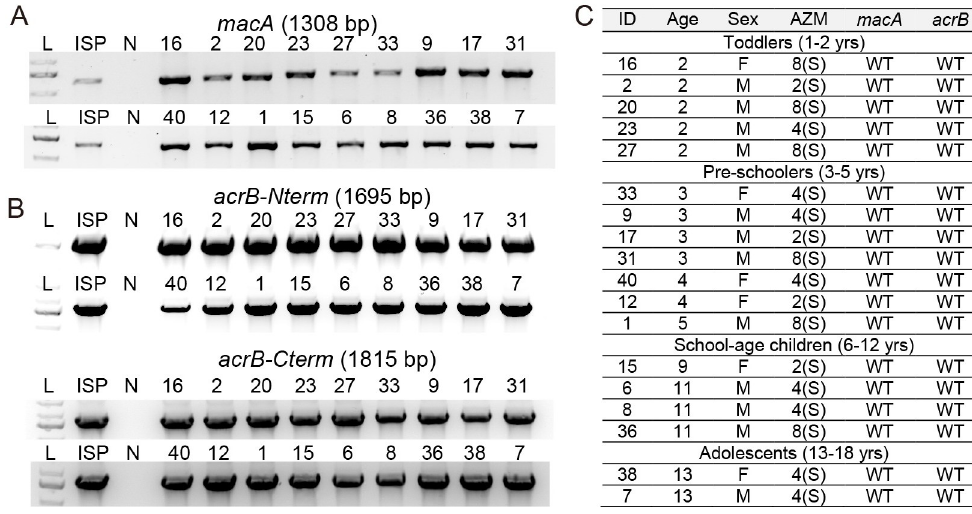
Fig 5. macA and acrB sequence analysis among XDR S . Typhi isolates. A-B , PCR reactions for macA ( A ) and acrB ( B ). acrB was split into two pieces for more productive PCR reaction outcomes ( acrB -Nterm and acrB -Cterm). ISP, antibiotic- susceptible S . Typhi ISP2825. N, negative control containing all PCR components except for S . Typhi genomic DNA. See S4 Table for details. C , Summary of PCR amplicon sequencing analysis for macA and acrB . WT, wild type for the known mutations. S, susceptible to